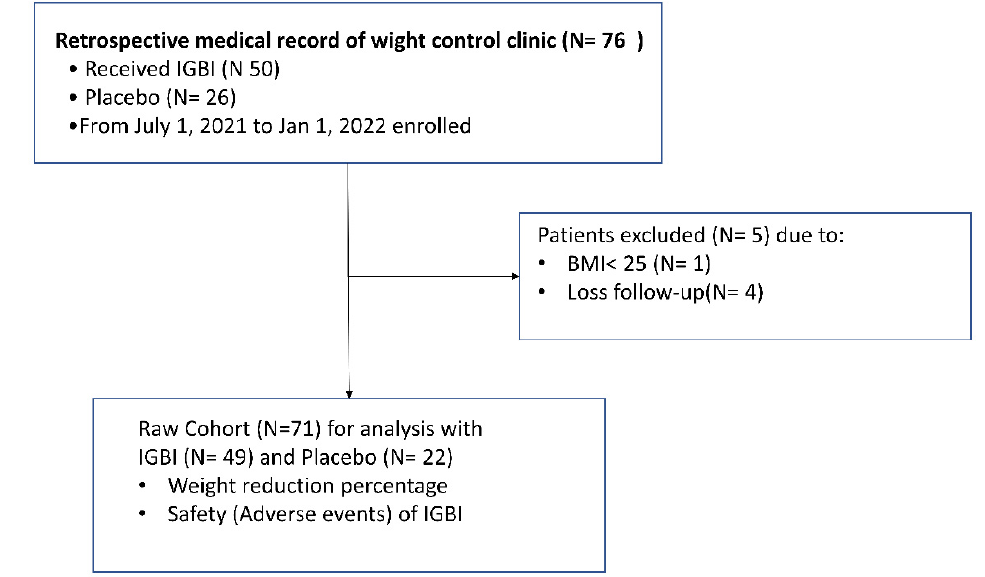
Figure 1. Study flowchart. Table 1. Baseline clinical characteristics of the